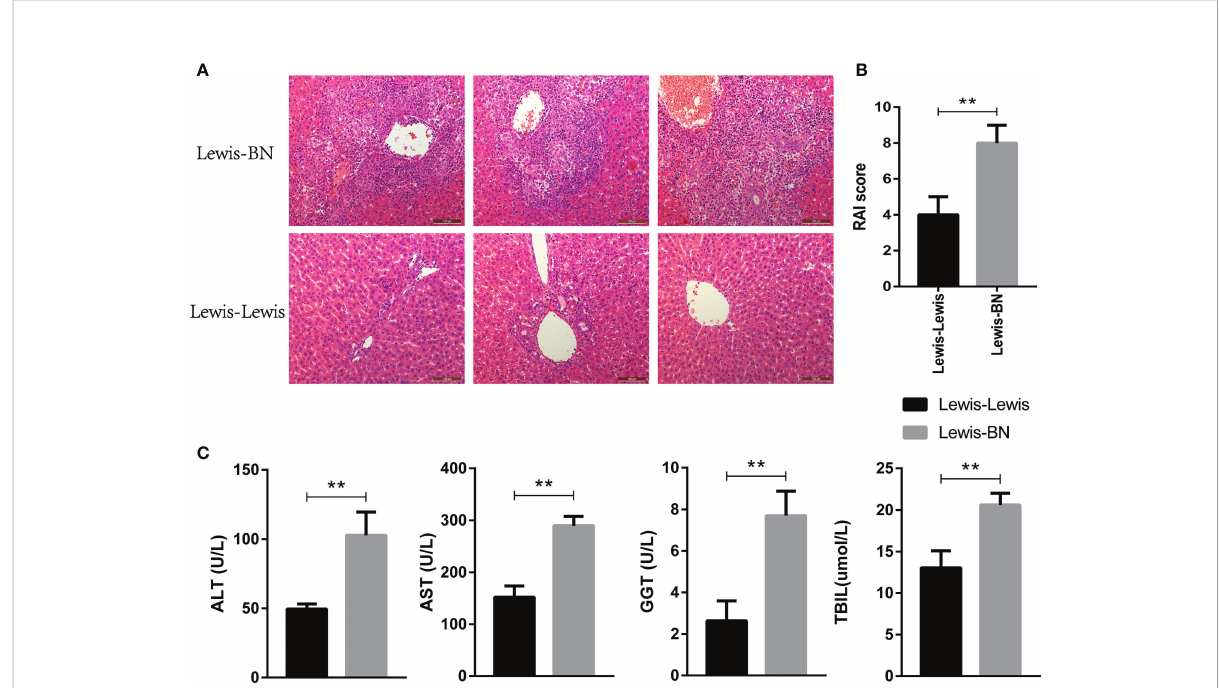
FIGURE 1 Validation of differences in liver transplantation rejection between Lewis-Lewis group and Lewis-BN group on POD 7. (A, B) Hepatic morphologic changes and RAI scores of recipient rats. (C) Peripheral blood of each group was taken for analysis and determination of serum aspartate aminotransferase (AST), alanine aminotransferase (ALT), g -glutamyl transpeptidase (GGT) and total bilirubin (TBIL) by automatic biochemical analyzer (N = 3). *P<0.05, **P < 0.01, ***P <